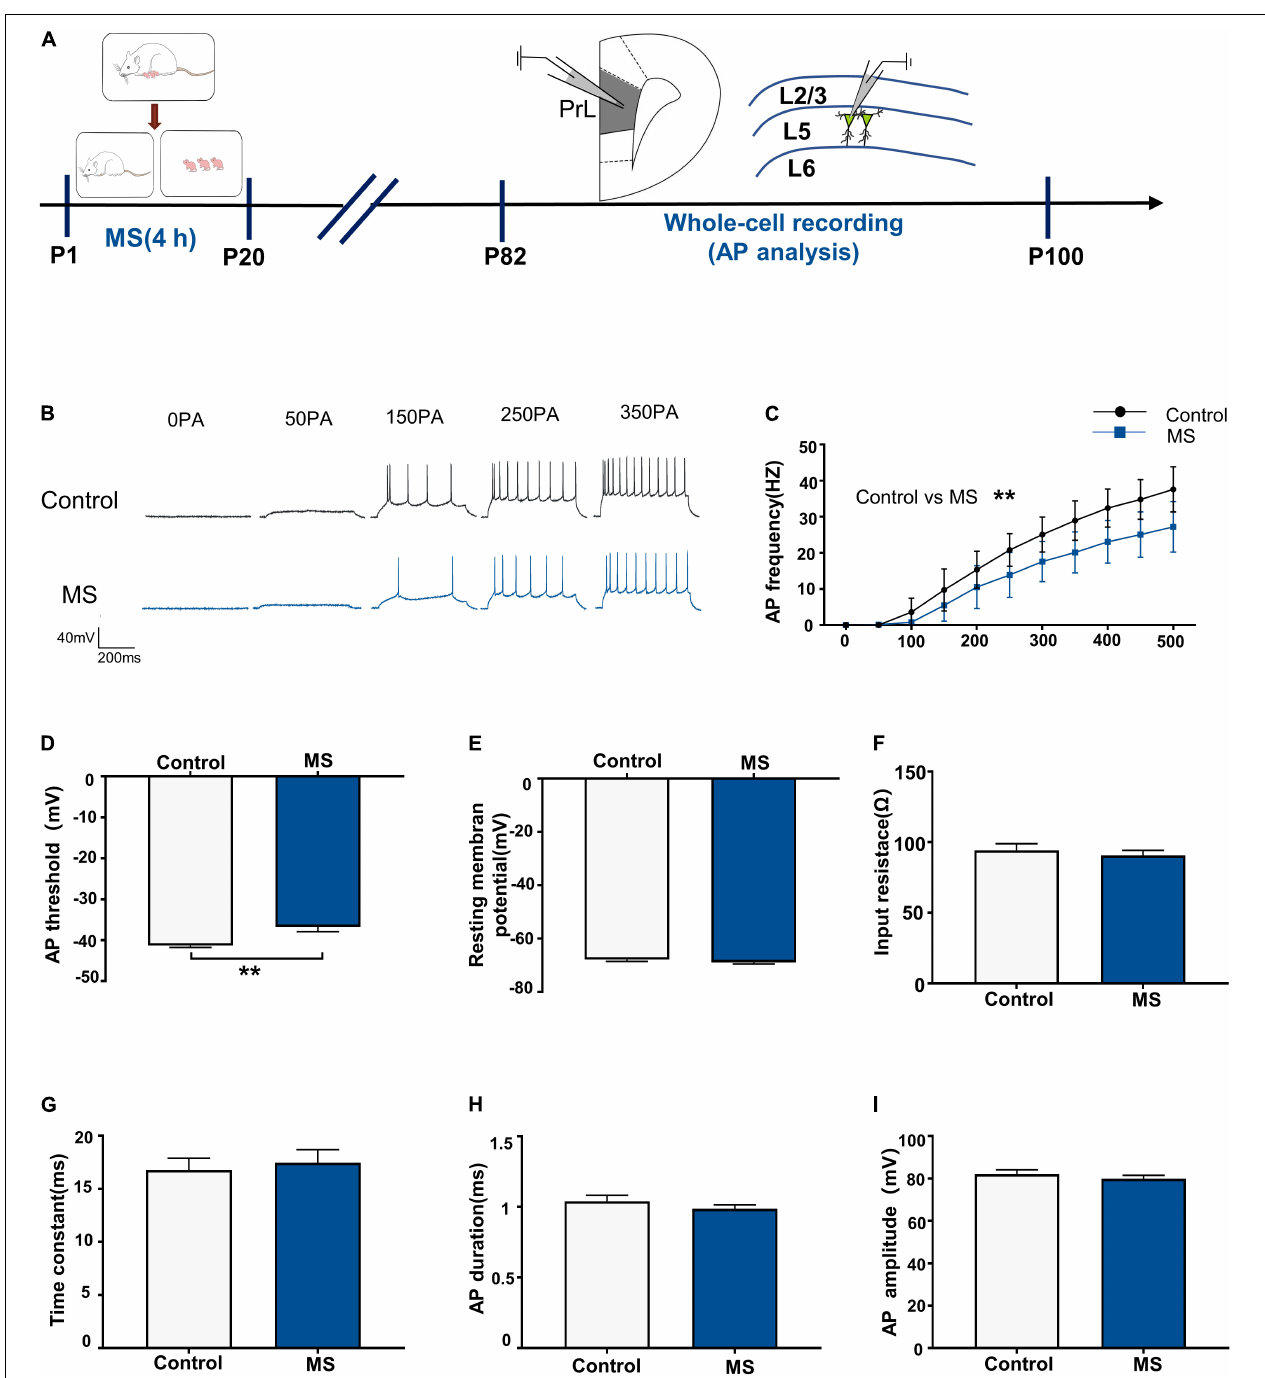
FIGURE 3 | Maternal separation induces a decrease in neuronal excitability in L5 pyramidal cells in adulthood. (A) The experimental timeline of MS, whole-cell recording (AP analysis). (B) Representative trace of AP from the L5 pyramidal cell in PrL with current clamp under the condition of injecting incremental step currents of 0, +50, +150, +250, and +350 pA in control and MS at adult. Scale bars: 40 mV, 200 ms. (C) The frequency of AP firing of pyramidal neurons in control and MS at adult. (D) The threshold of action potential of pyramidal neurons in control and MS at adult. (E) The resting membrane potential of action potential of pyramidal neurons in control and MS at adult. (F) The input resistance of action potential of pyramidal neurons in control and MS at adult. (G) The membrane time constant of action potential of pyramidal neurons in control and MS at adult. (H) The duration of the action potential measured at half-amplitude of pyramidal neurons in control and MS at adult. (I) The amplitude of action potential of pyramidal neurons in control and MS at adult. * p < 0.05, ** p < 0.01. Data are the means ± SEM ( n = 15 cells from 3 to 4 rats each group).